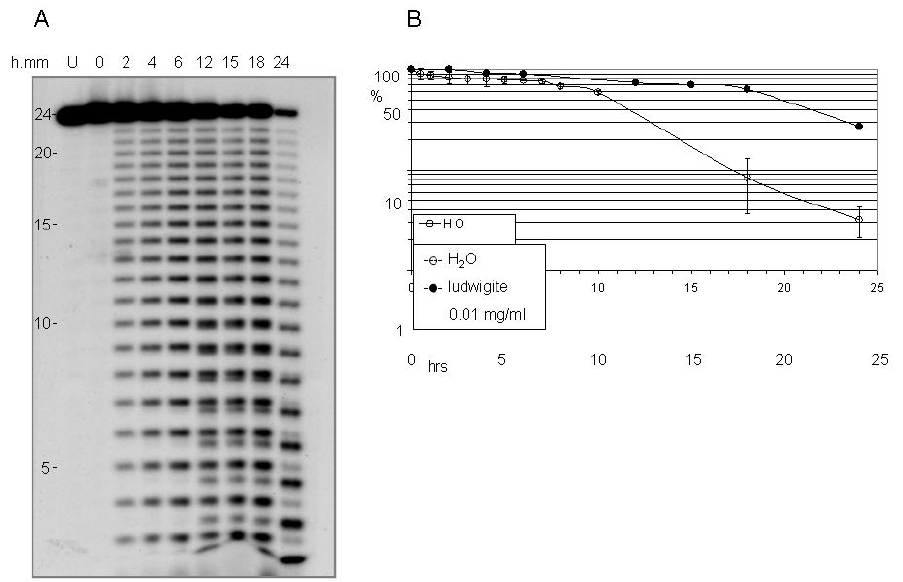
Figure 6. RNA protection in water by ludwigite , performed as described in Figures 2 and 5, for the indicated time spans (panel A). The plot in panel B shows the remaining full-length molecules (%) at the indicated time in the presence (•) or in the absence ( ○ ) of